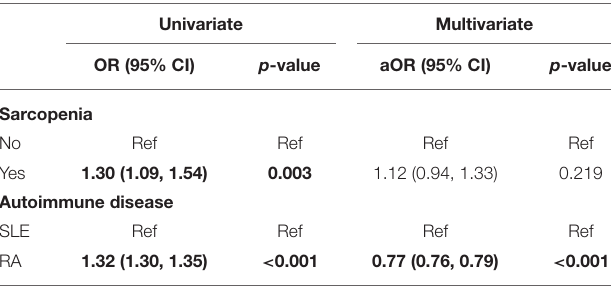
TABLE 4 | Associations between sarcopenia, type of autoimmune disease and the presence of HF. Univariate Multivariate